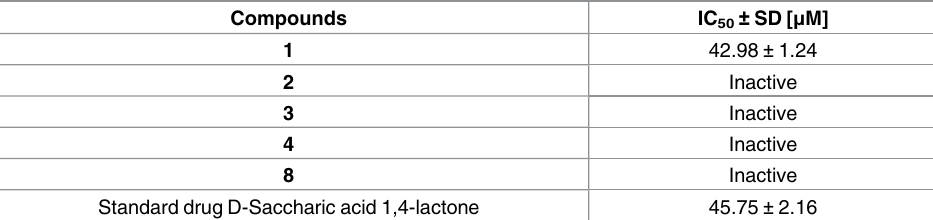
Table 3. In vitro β -glucuronidase inhibitory activity of mibolerone (1), and its